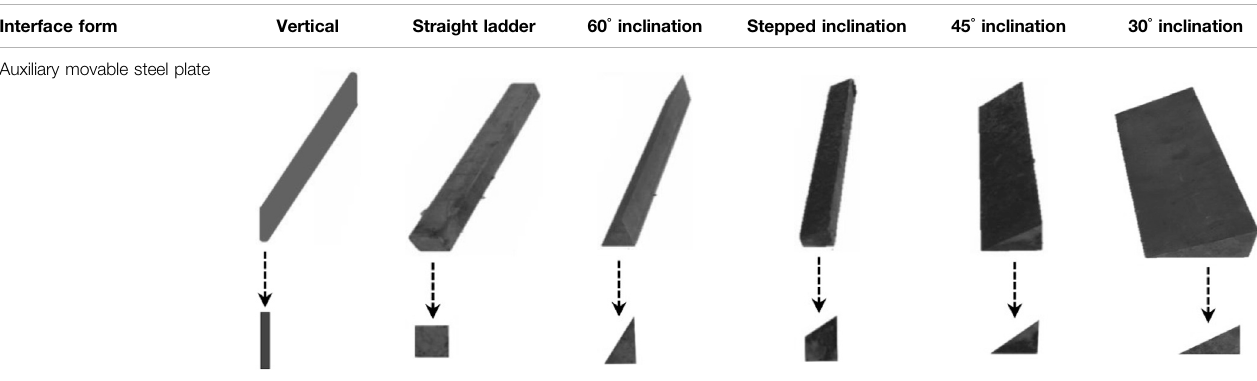
TABLE 3 | Auxiliary movable steel plate with different bonding surface forms. Interface form